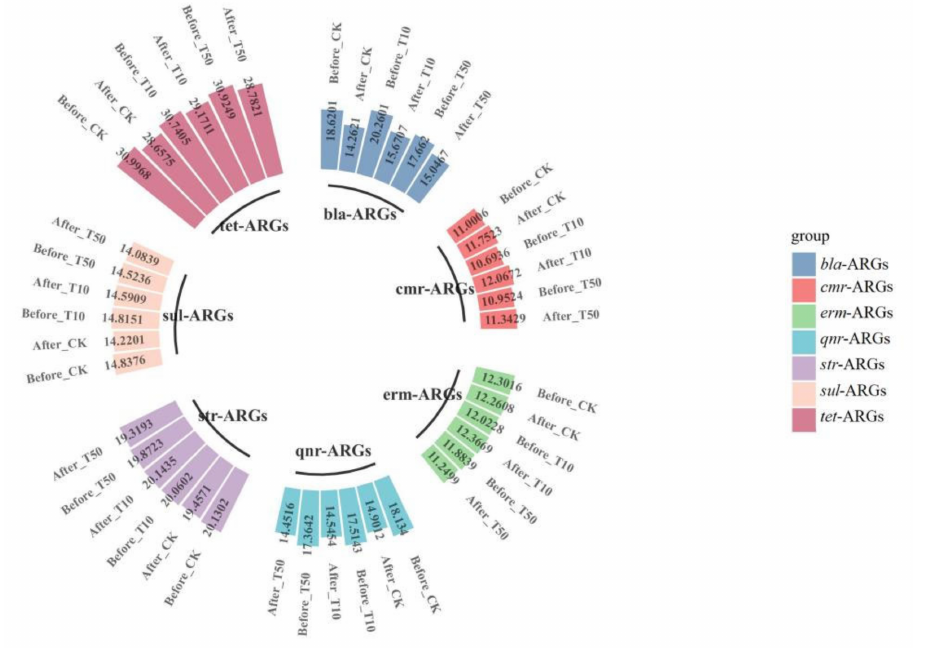
Figure 7. The absolute concentrations (lg) of various genes in fresh casts and before and after vermicomposting. The concentrations of resistance genes in fresh casts and products before and after vermicomposting were compared in the pollution treatment without and with different concentrations of